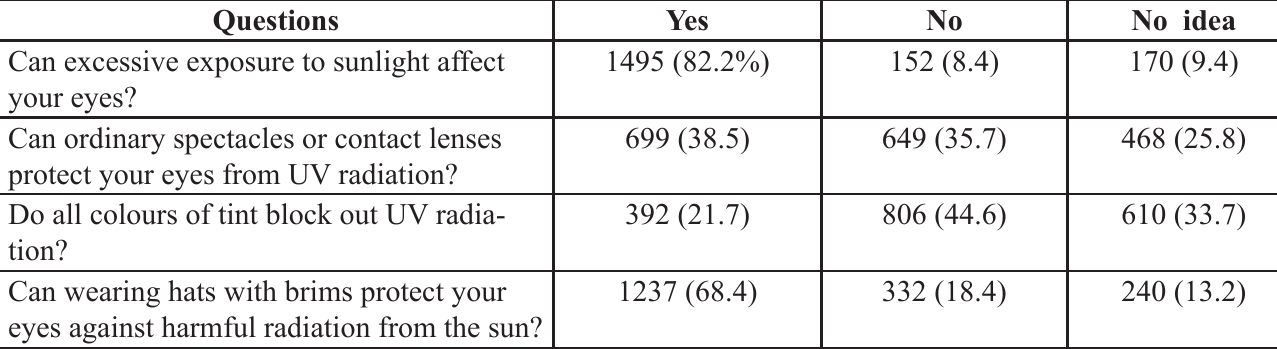
Table 1: The number and percentages (in parentheses) of all participants who responded to the questions are indicated in the table. The number and percentages of participants who got the answers correct varies significantly.